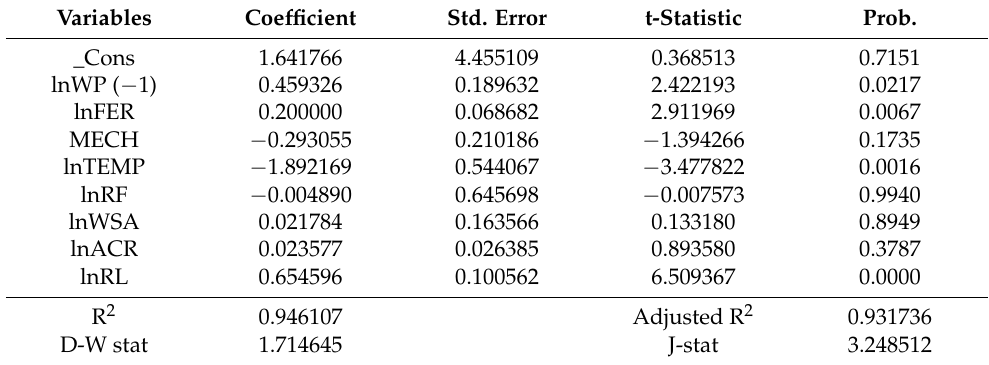
Table 5. The impact of technological progress and climate change on wheat production (Model 2). Variables Coefficient Std. Error t-Statistic Prob. _Cons 1.641766 4.455109 0.368513 0.7151 lnWP ( − 1) 0.459326